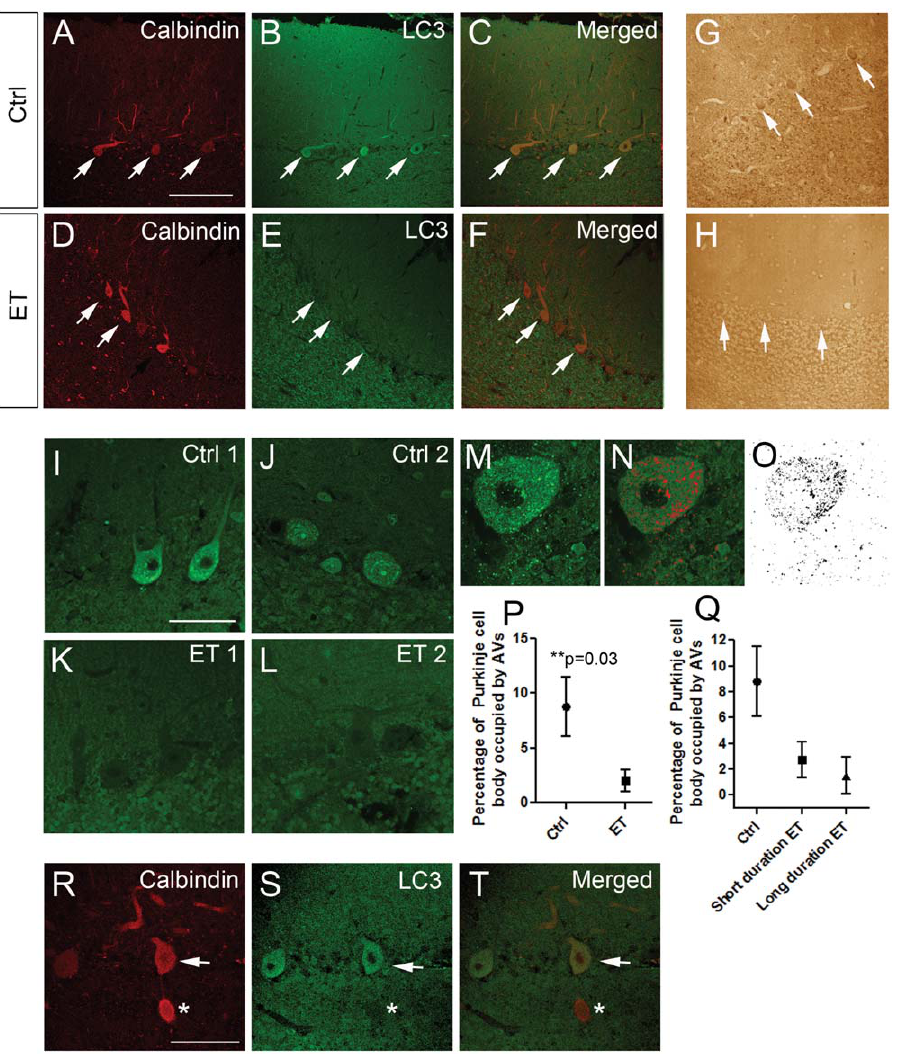
Figure 2. LC3-II immunohistochemistry in PCs was decreased in ET cases vs. controls. Cerebellar cortical sections from controls (A–C) and ET cases (D–F) were double immunolabelled with anti-calbindin and Alexa 594 (A, C, D, F, red), or with anti-LC3 and Alexa 488 (B, C, E, F, green) and imaged by confocal microscopy using the same acquisition parameters. LC3 signals are much stronger in PCs (white arrows) in control (B) than in ET case (E). We also labeled the cerebellar cortical sections with anti-LC3 antibody conjugated with avidin/biotin complex and horseradish peroxidase and stained with 3,3 9 -diaminobenzidine (DAB) (G, H, brown). PCs exhibited stronger immunolabelling with DAB in control (G) than ET case (H). Scale bar: 200 m m. Higher magnification confocal images of PCs stained with LC3 and Alexa 488 showed that controls (I, J) contained more LC3 puncta than ET cases (K, L). Scale bar: 50 m m. Using image J, we further analyzed the percentage of PC body occupied by AVs (M–O). The percentage of PC body occupied by AVs was significantly lower in ET cases than controls (P). We further divided our samples into three groups including controls, short duration ET group, and long duration ET group and compared the LC3-II clustering. LC3-II clustering was highest in the controls and lowest in the long duration ET group (Q). A cerebellar cortical section was stained with calbindin (R, red) and LC3 (S, green) in a case of ET. A PC body (arrow) and an axonal torpedo (asterisk) were identified by the positive calbindin staining (R). Axonal torpedo did not display any LC3 staining (S, T). Scale bar: 50 m